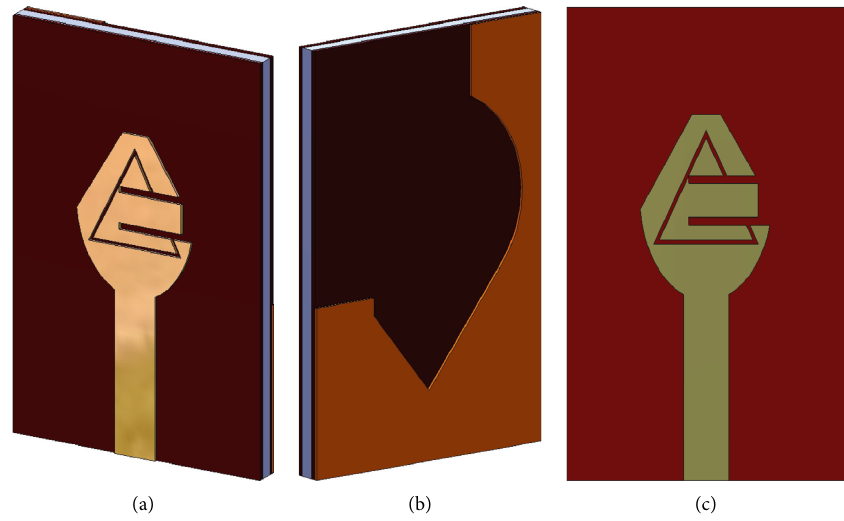
Figure 1: Miniaturized antenna model in different views: (a) 3D front, (b) 3D back, and (c) front.